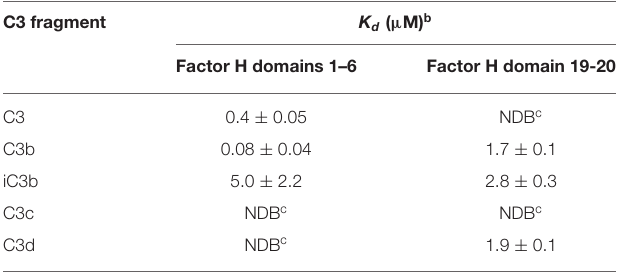
TABLE 2 | Specificity and affinity a of the N- and C-terminal regions of Factor H for different C3 fragments. C3 fragment